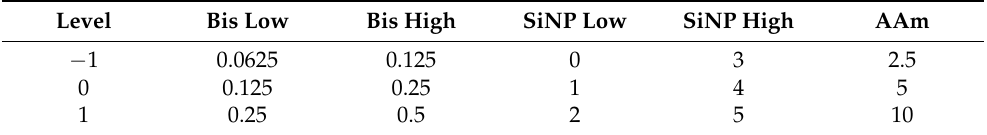
Table 1. Three level factorial designs for the single network data. Values in the table are substituted for the levels on the left for the purpose of the factorial design. Each factorial design includes one Bis set (Bis Low or Bis High), one SiNP set (SiNP Low, or SiNP High), and the acrylamide set. Level Bis Low Bis High SiNP Low SiNP High AAm − 1 0.0625 0.125 0 3 2.5 0 0.125 0.25 1 1 0.25